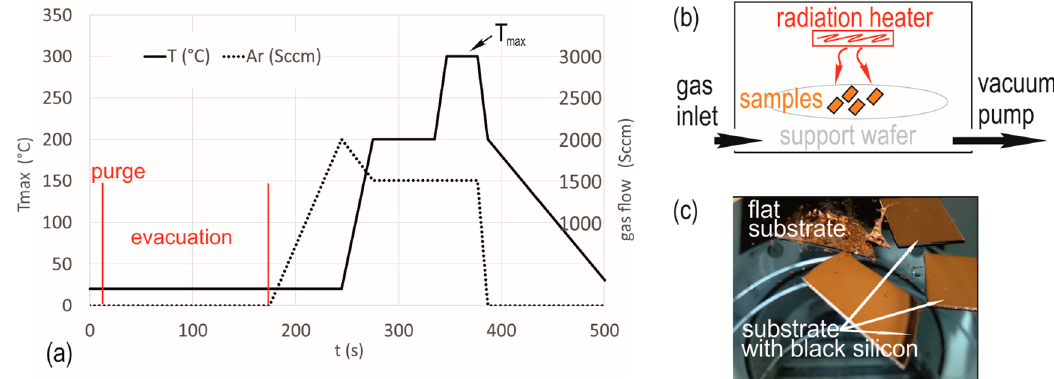
Figure 3. Rapid thermal annealing (RTA) process. ( a ) Temperature profile with gas flow regime, T max varies between 350 °C and 550 °C, the heat-up time is 12 s and plateau time 30 s; ( b ) schematic of RTA set-up; ( c ) photograph of treated samples on support wafer.